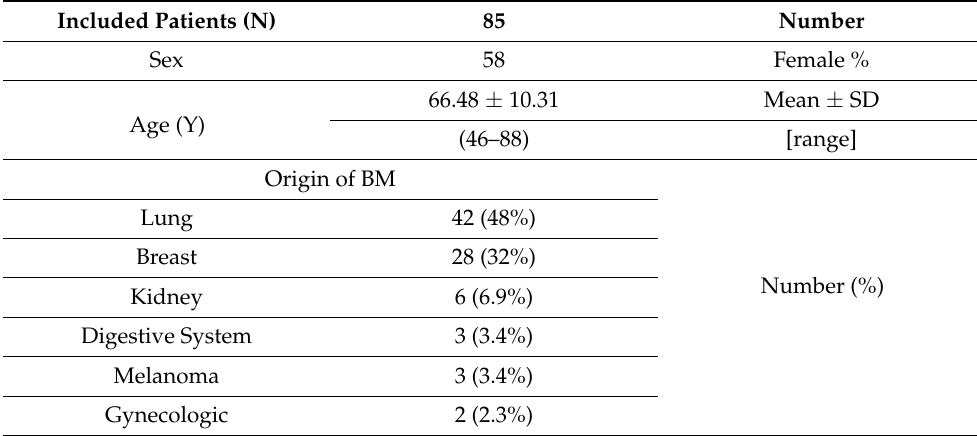
Table 1. Description of the patient